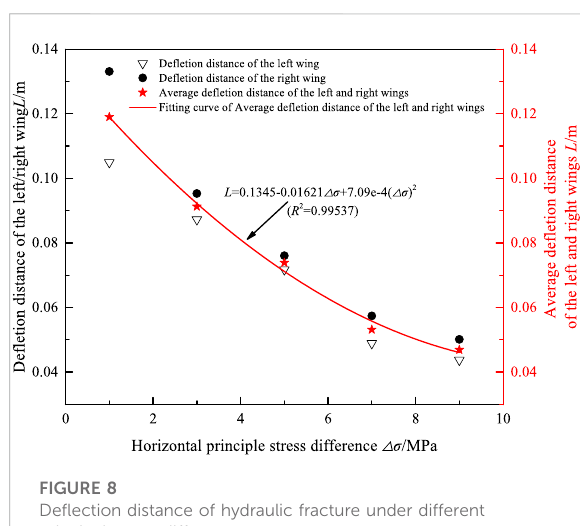
FIGURE 7 De fl ection trajectory of hydraulic fracture under different principal stress difference.